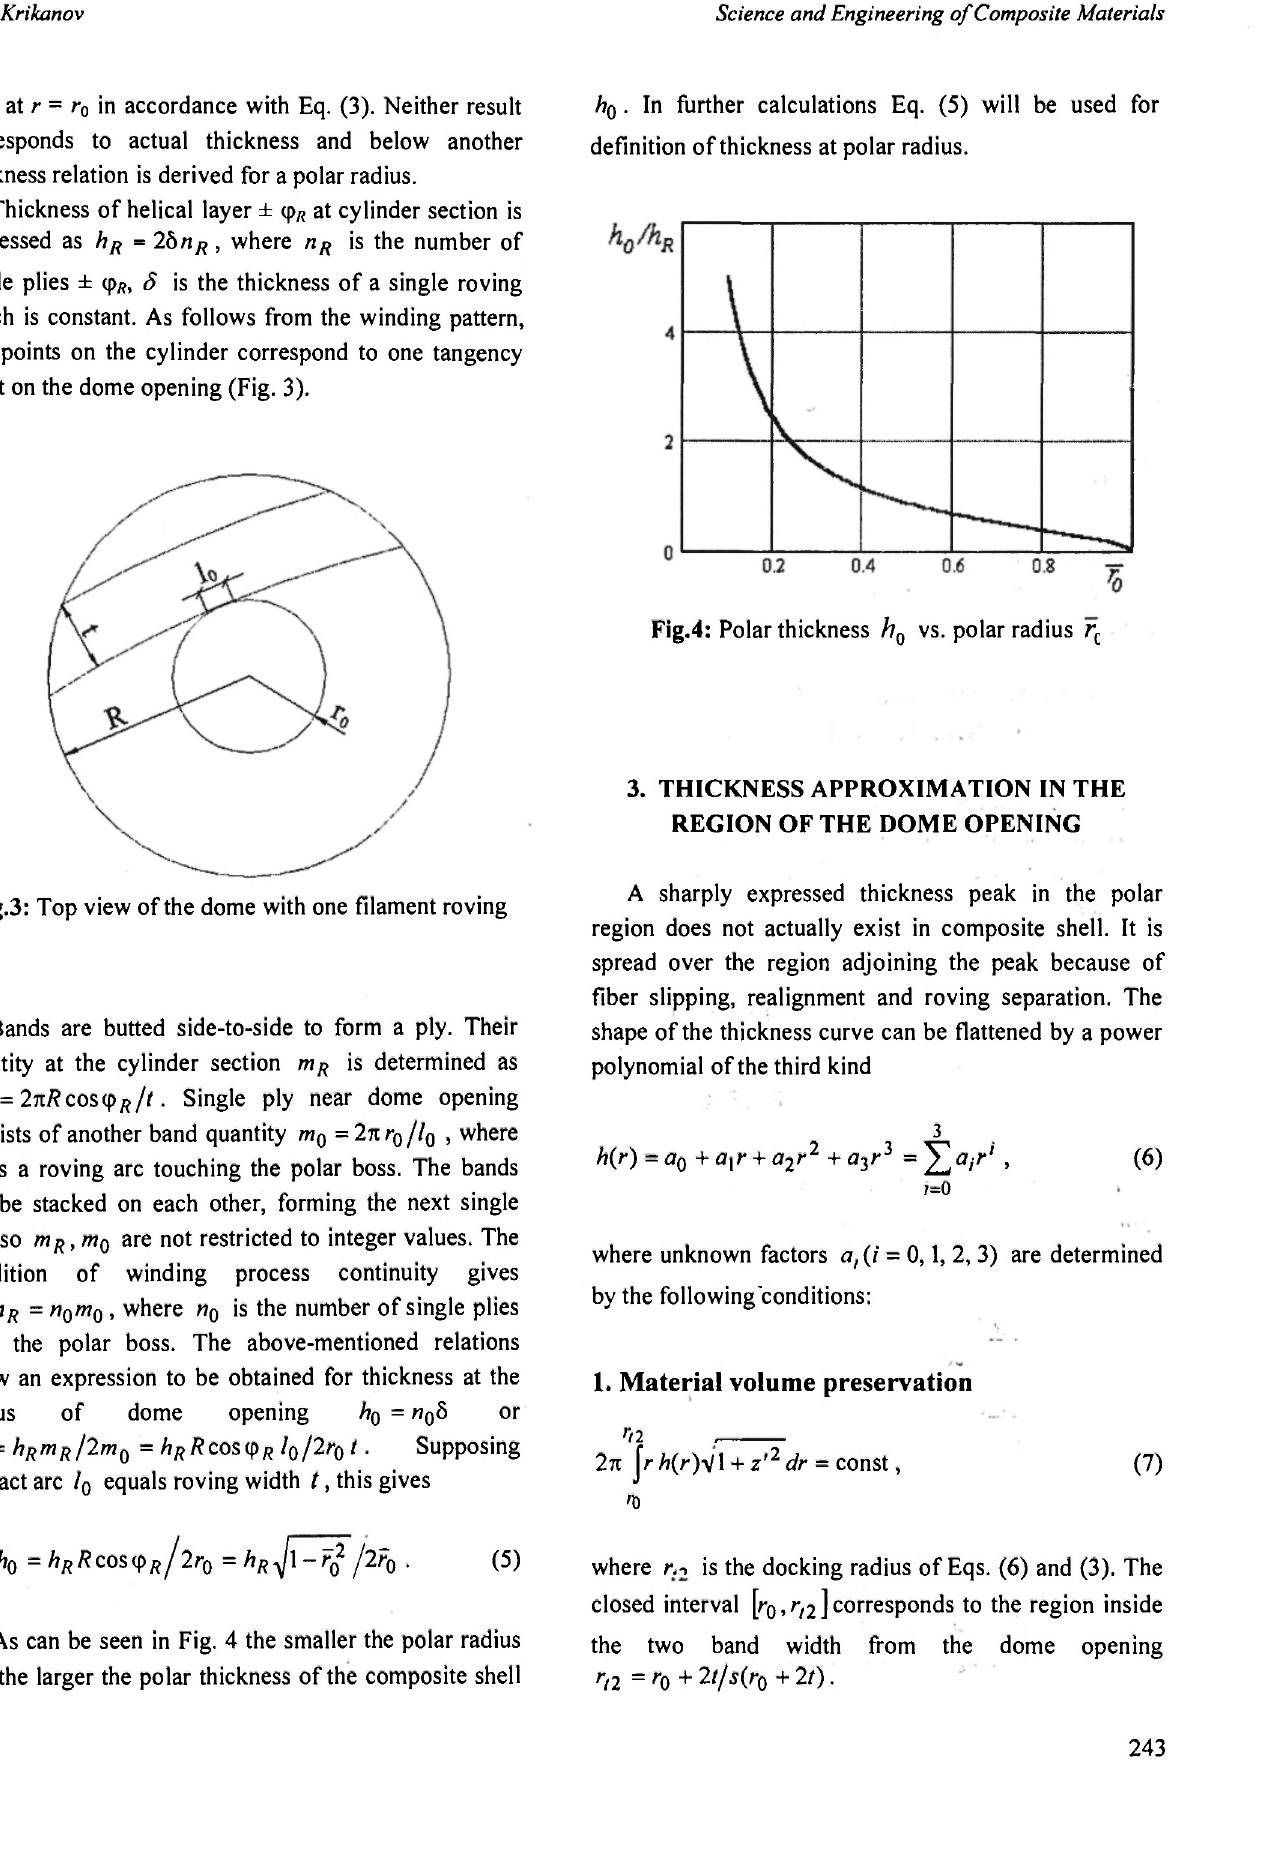
Bands are butted side-to-side to form a ply. Their quantity at the cylinder section m R is determined as m R = 2nRcosy R /t. Single ply near dome opening